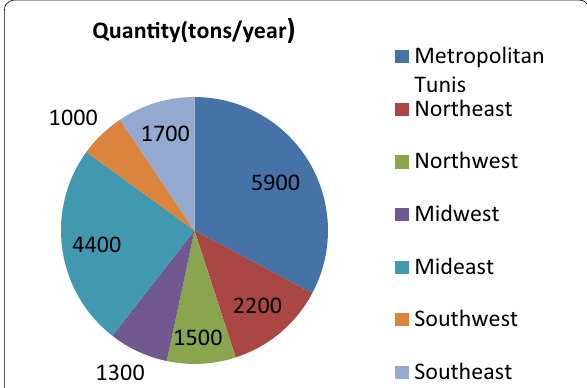
Fig. 2 The quantity of green waste from municipal and wholesale markets